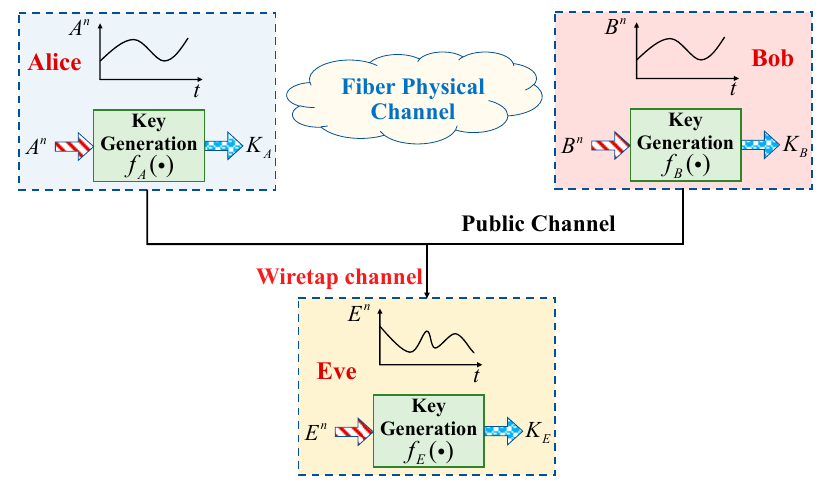
Figure 1. Key generation model diagram.